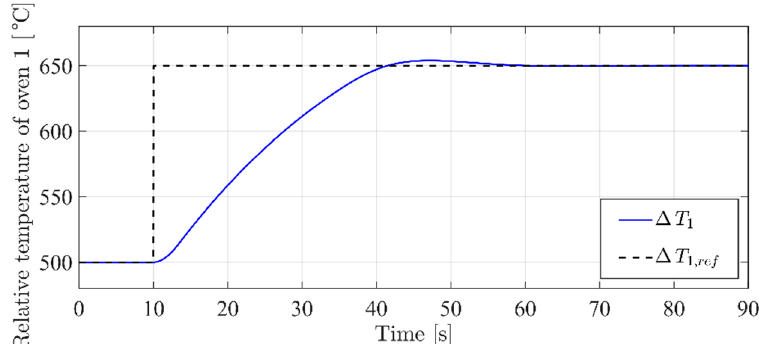
Figure 6. 𝛥𝑇 (cid:2869) time profile. Figure 6. ∆ T 1 time profile.